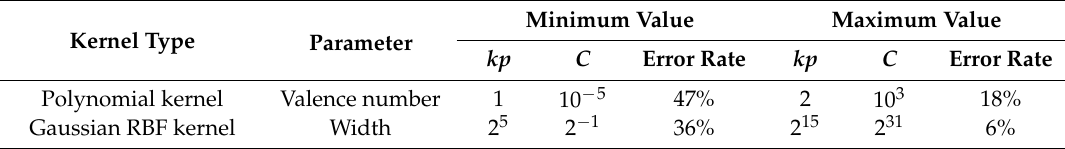
Table 4. Statistics of the parameter initial range.